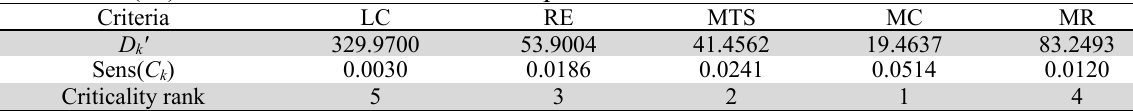
D' k and Sens( C k ) values for robot selection Example 1 Criteria